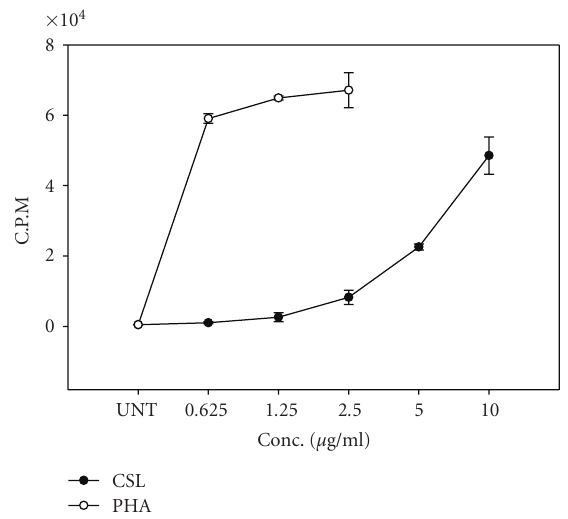
Figure 4: Mitogenic activity of CSL. PBMCs were isolated from blood of healthy donors and exposed to serial concentrations of CSL (0.625–10 μ g/ml) and PHA-L (0.16–2.5 μ g/ml) for 72 hours and proliferation was measured by tritiated thymidine incorporation assay as counts per minute (CPM). The data are presented as mean ± SE of four independent experiments done in triplicates.